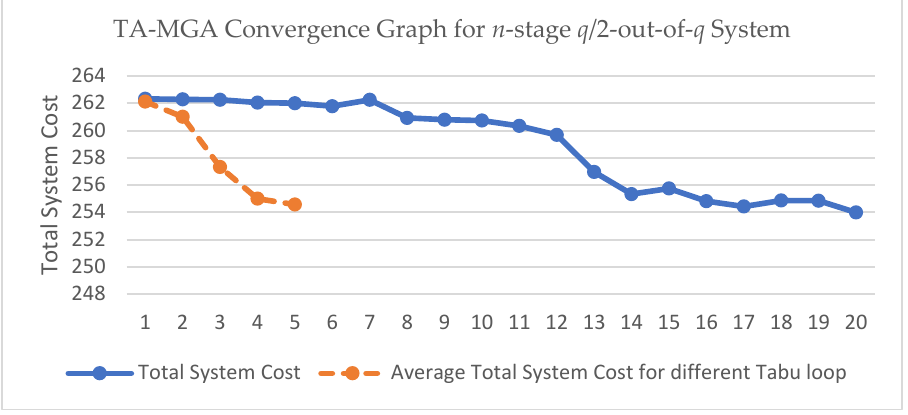
Figure 14. The convergence graph of the n -stage q/2 -out-of- q system for the TA–MGA combined method.